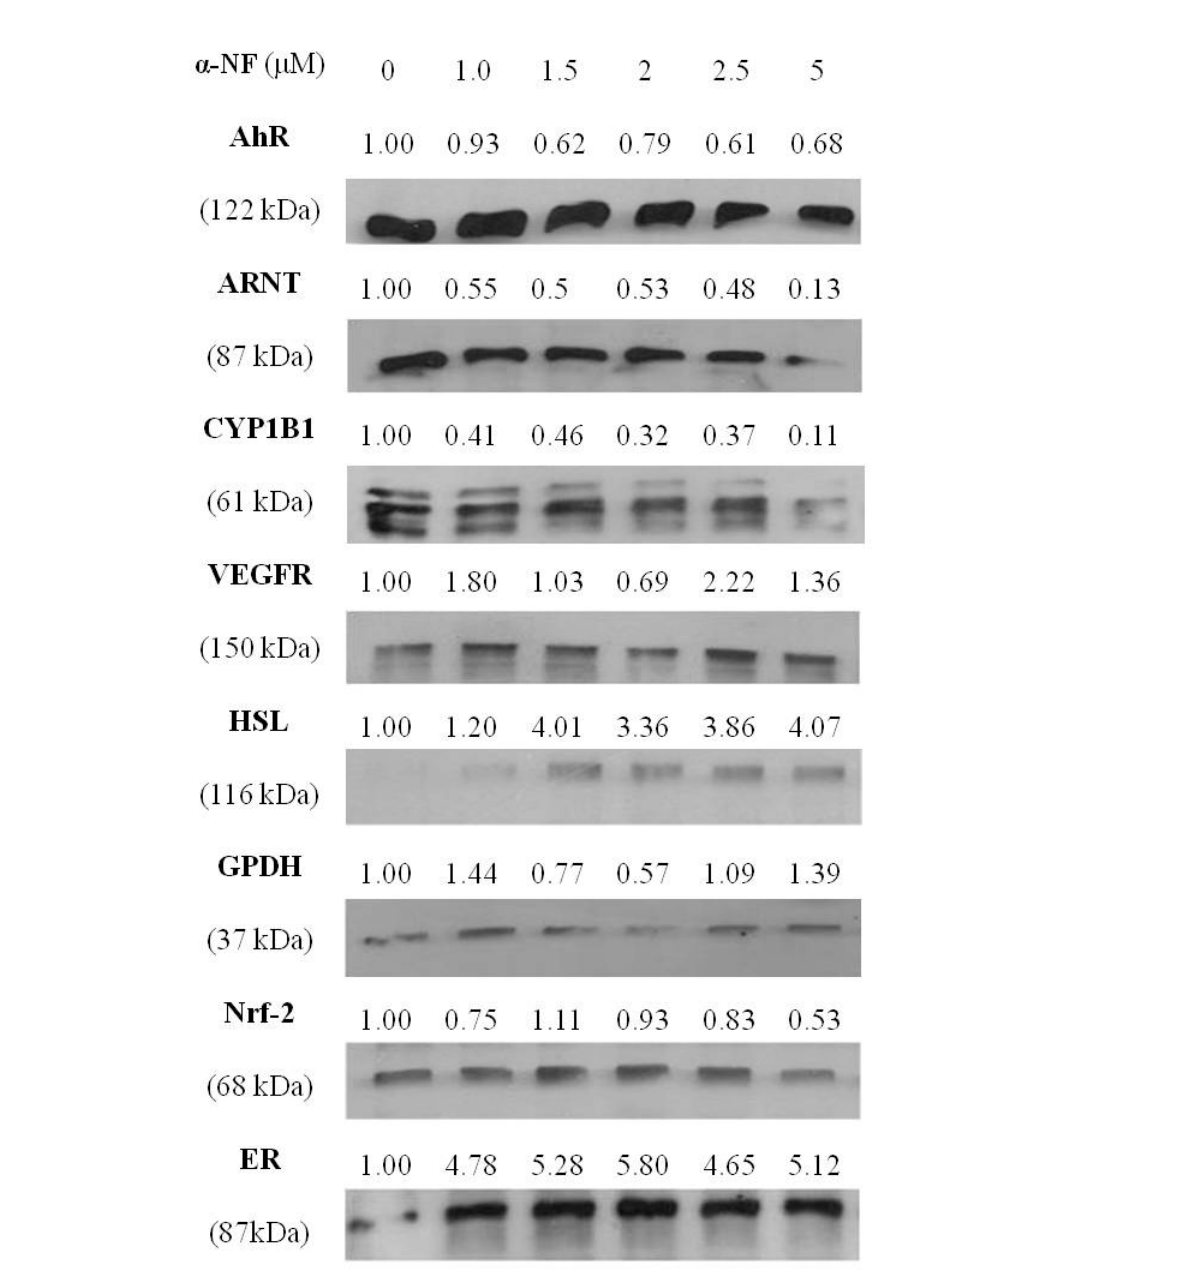
Figure 5. Effects of α-naphthoflavone (α-NF) on the aryl hydrocarbon receptor (AhR), the AhR nuclear translocator (ARNT), cytochrome P4501B1 (CYP1B1), estrogen receptor (ER), hormone-sensitive lipase (HSL), glycerol phosphate dehydrogenase (GPDH), nuclear factor erythroid 2-related factor 2 (NRF2), and vascular endothelial growth factor receptor (VEGFR) protein expressions by differentiated adipocytes. After full differentiation, adipocytes were treated with various concentrations of α-NF in Dulbecco’s modified Eagle’s medium (DMEM) containing 1% fetal bovine serum (FBS) for 16 h, and proteins were collected and then measured with a Western blot analysis. Levels of protein are expressed relative to the cells treated with no α-NF after being normalized by β-actin expression. Pictures are representatives of three independent